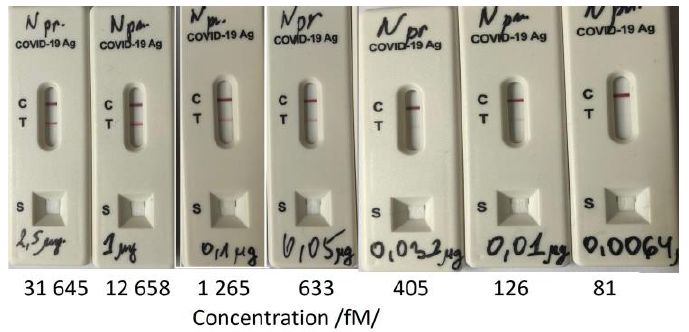
Figure 9. Concentration dependences for N/S proteins obtained via ELISA.